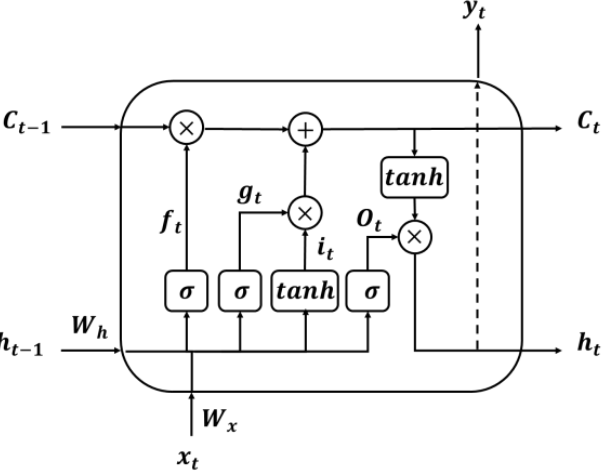
Figure 1. Conceptual structure of the long short-term memory (LSTM).